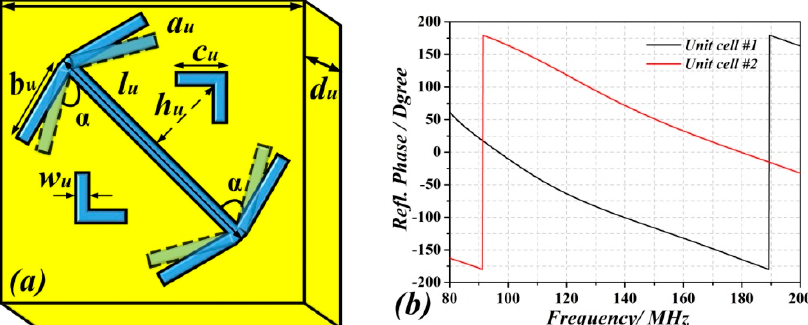
Figure 2. ( a ) Layout and geometrical parameters of the metasurface unit cell proposed: a u = 330 mm, b u = 300 mm, c u = 143.9 mm, h u = 177.6 mm, l u = 532.8 mm, w u = 44.4 mm, α = 79° (unit cell #1), α = 66° (unit cell #2). The thickness of metallic patterns is 0.035 mm. The F4B-2 woven glass polytetrafluoroethylene dielectric substrate with thickness d u = 300 mm, dielectric constant ε r = 2.65 and tan δ = 0.001 has been considered. (b) Reflection phase of the unit